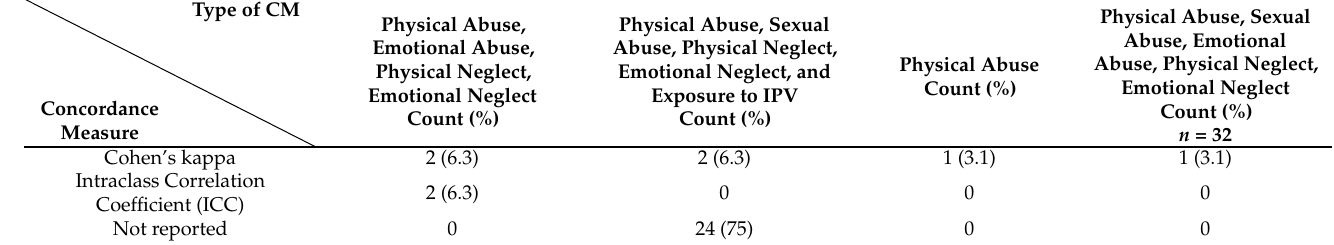
Table 6. Concordance measures between informants and type of child maltreatment reported.